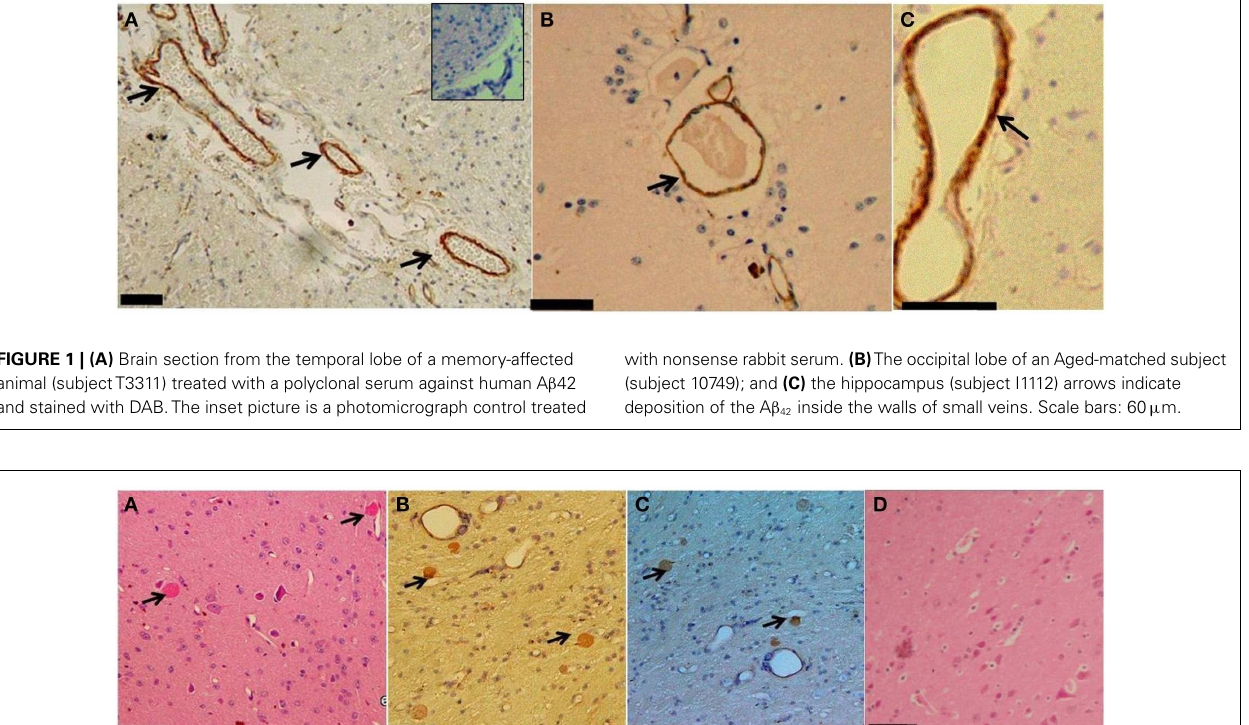
FIGURE 2 | Brain section of the frontal lobe from a Memory-affected animal (subject I1112) demonstratingA β 42 plaques in the parenchyma, (A) stained with HE, (B) Congo red and (C) with anti-A β 42 antiserum/DAB, and (D) HE fromAged-matched subject (subject 10749) . Arrows indicate A β 42 plaques. Scale bars: 60 µ